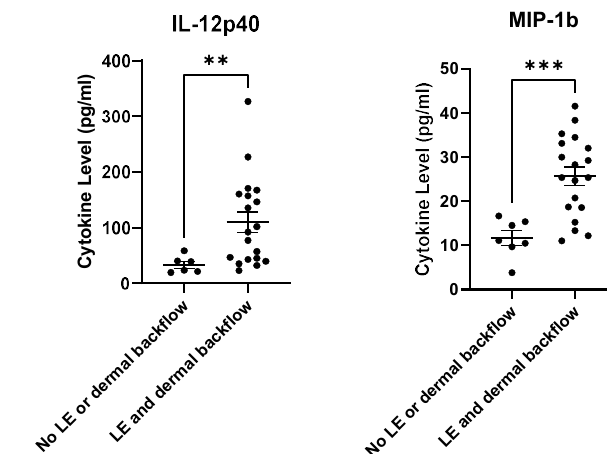
Figure 7. GM-CSF, IFN- α 2, IL-12p40, IL-15, IL-6, TNF- α , and MIP-1 β were significantly higher